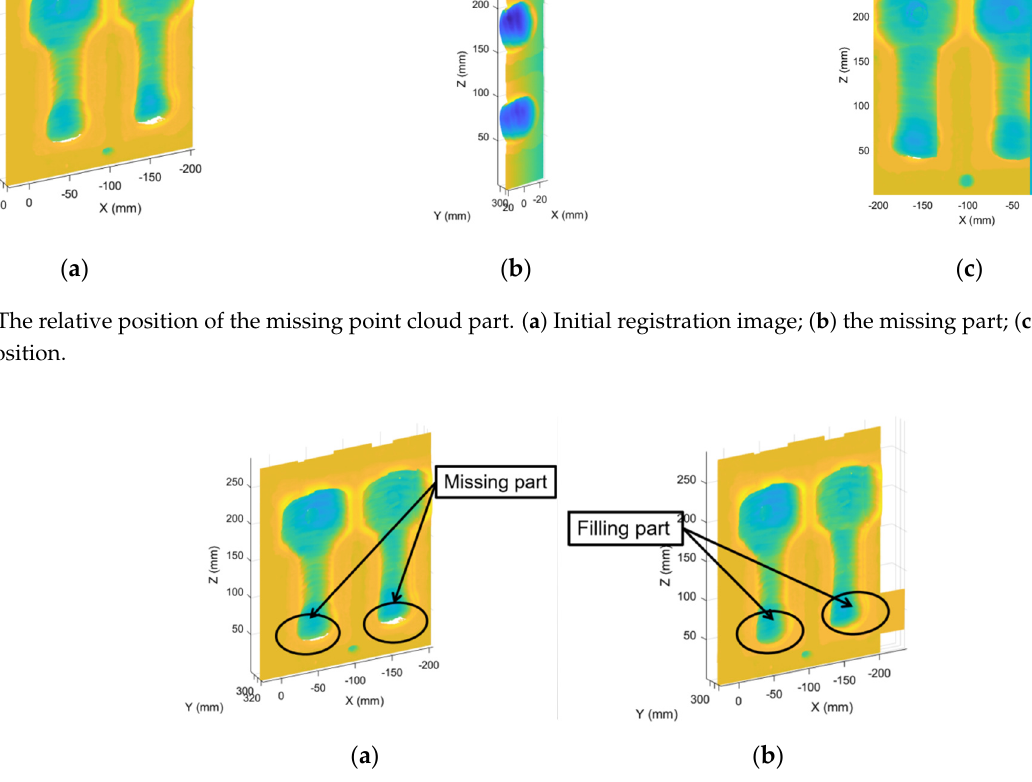
Figure 3. OICP algorithm to fill in the missing part. ( a ) Initial registration image; ( b ) final registra- tion image.